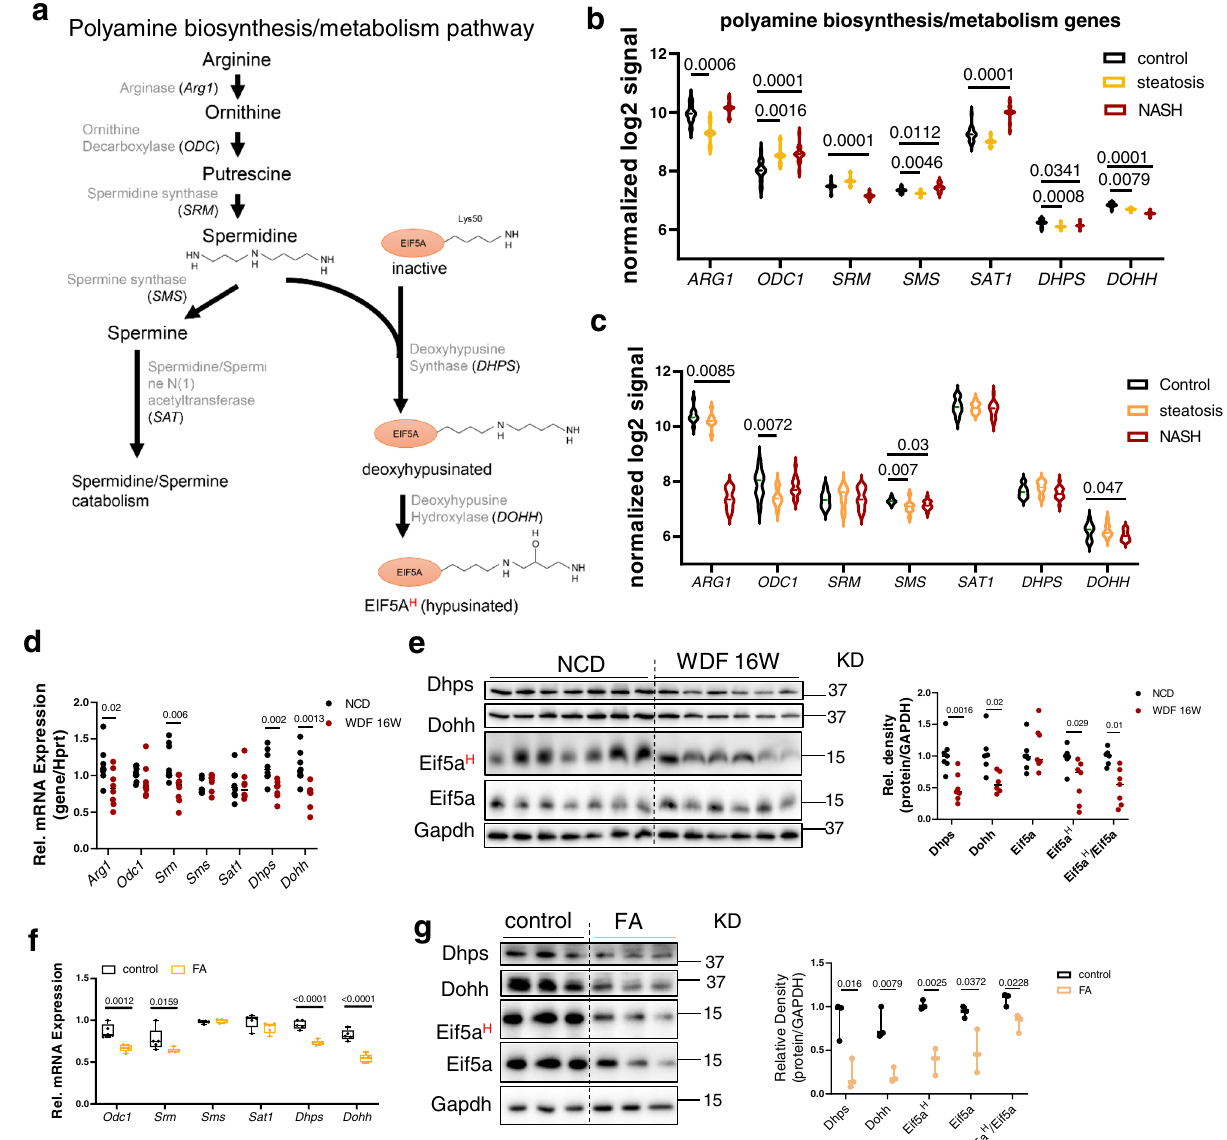
Fig.1|DecreasedDHPS-DOHH-EIF5A H pathwayinNAFLD.a Polyaminesynthesis and hypusination of EIF5A pathway in eukaryotic cells. Enzymes ARG1 , ODC , SRM areinvolvedinconvertingargininetospermidine. DHPS and DOHH